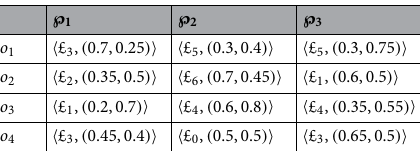
Table 6. Normalized decision matrix provided by d 3 .